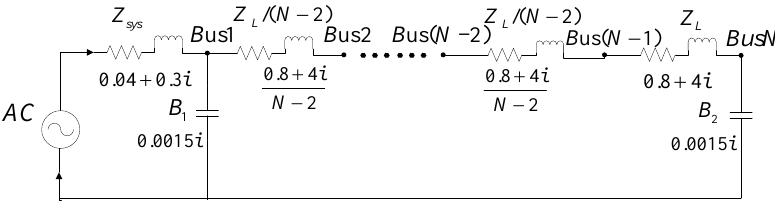
Figure 7. The universal N-bus benchmark.